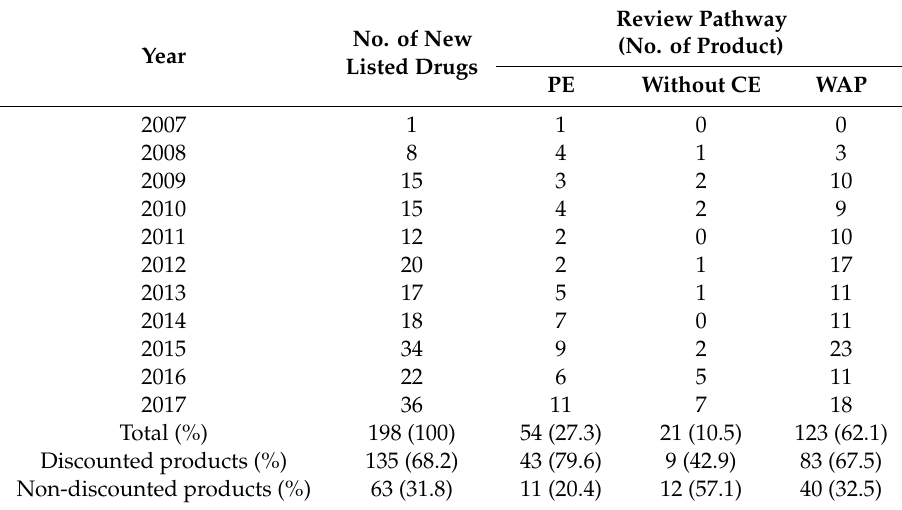
Table 1. Categorization of new listed drugs by review pathway (2007–2017). No. of New Year Listed